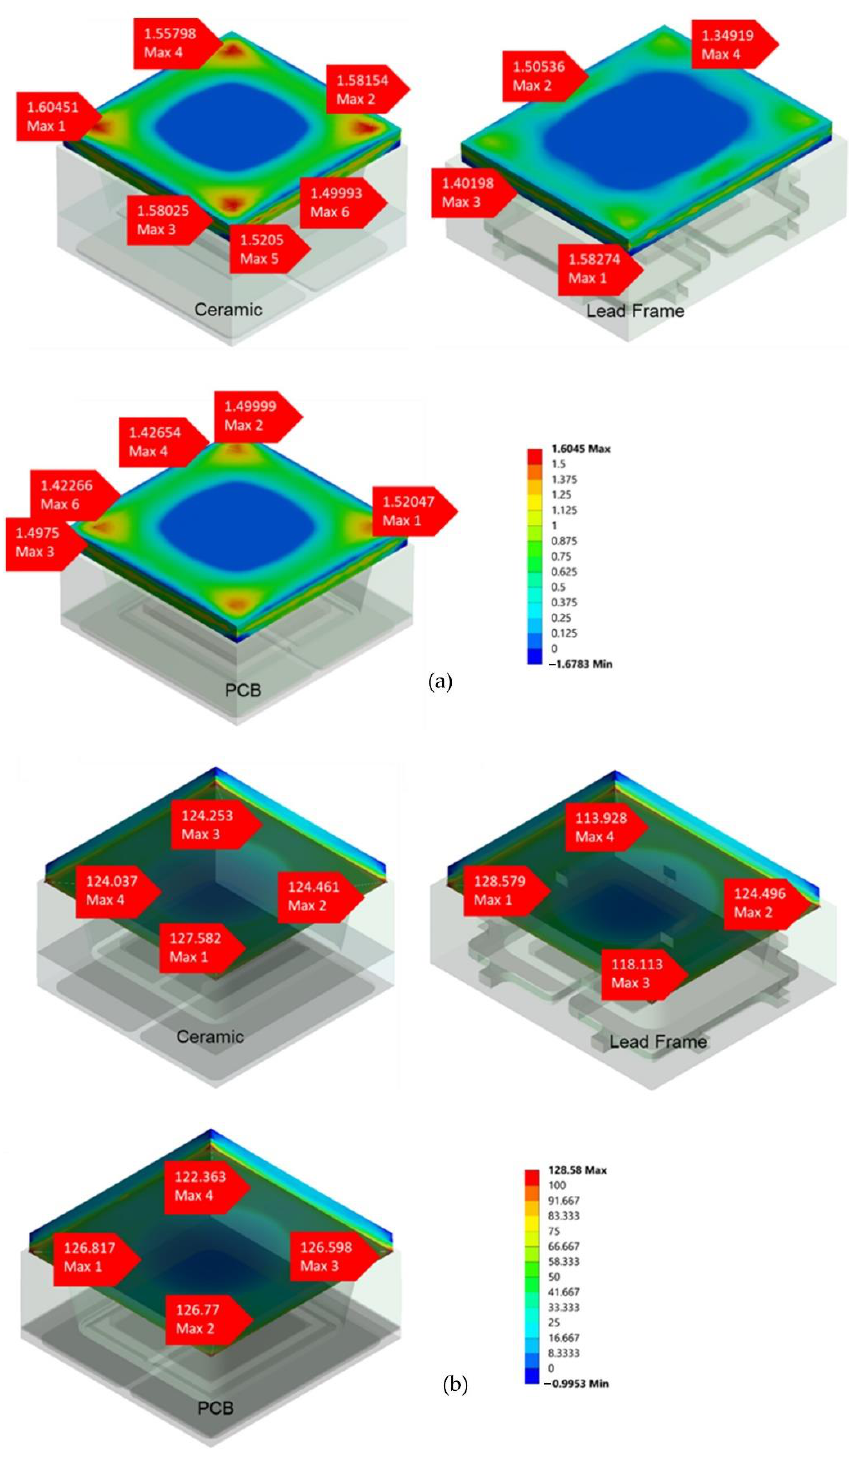
Figure 12. The 3D image of the stress value at the lens area for three types of VCSEL packages during mechanical stress simulation at ( a ) high temperature of 260 °C and ( b ) low temperature of − 40 °C.